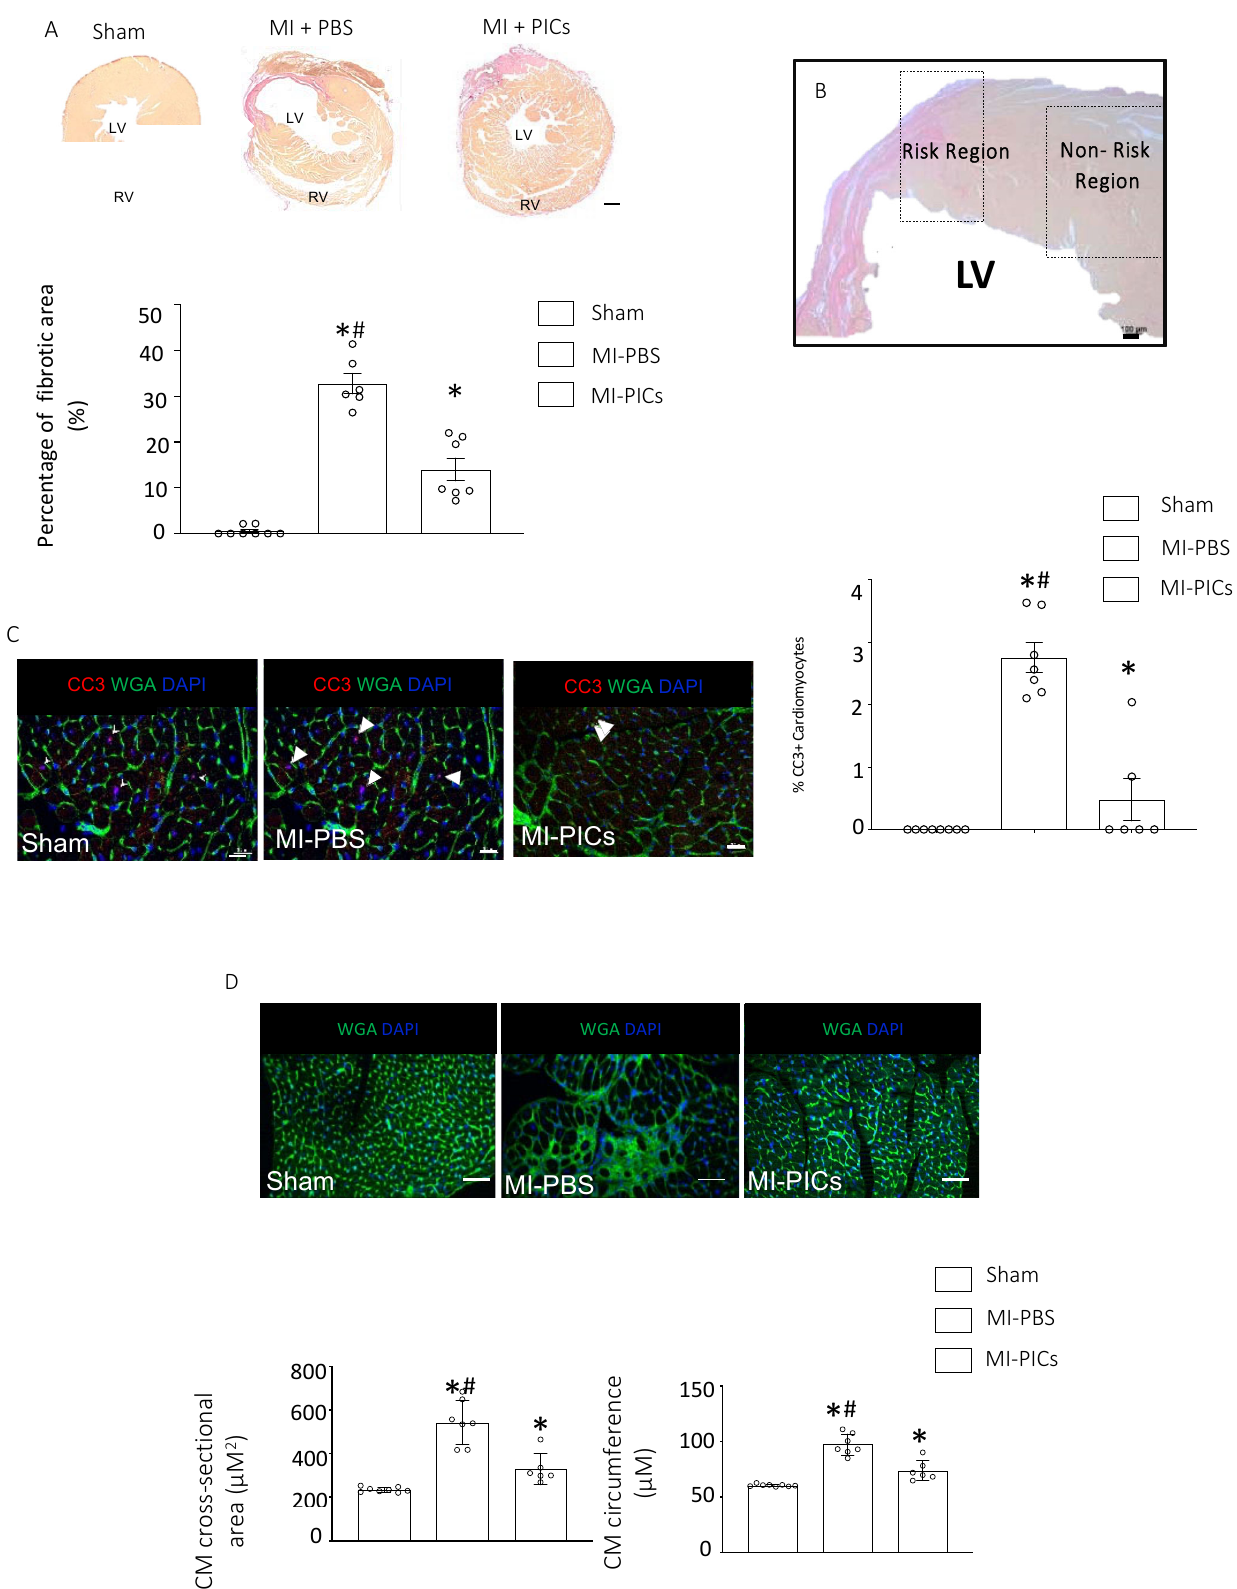
Figure 2. PIC transplantation attenuates cardiac remodelling after MI. ( A ) Fibrosis detection using hematoxylin van geisen (HVG) staining in Sham = 8, MI-PICS = 7 and MI-PBS = 7, pink/red staining indicates fibrosis. Data expressed as Mean ± SEM of the fibrotic area over the total area of the left